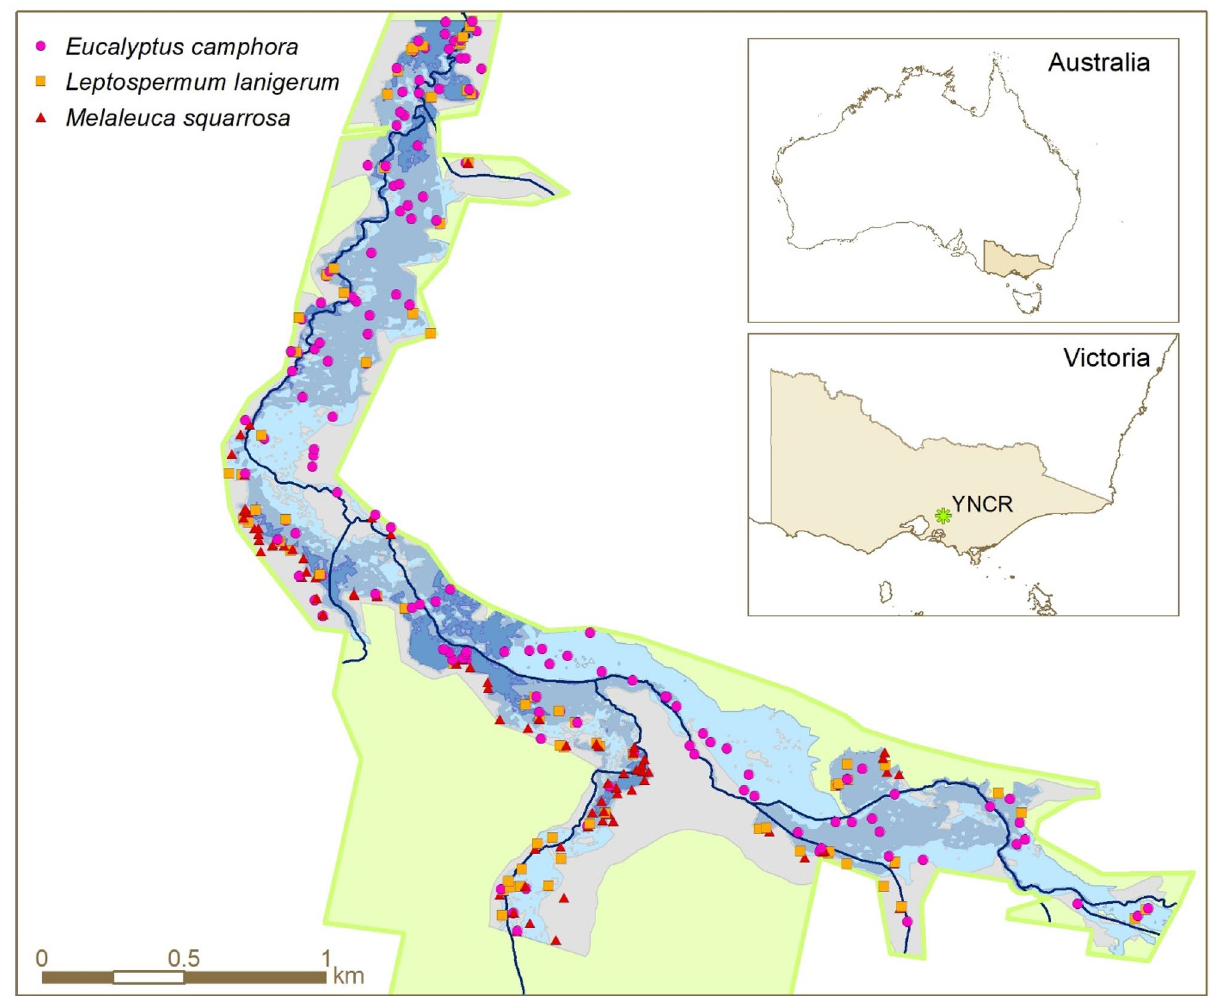
Figure 2. Map of all surveyed individuals of the three studied species within the Yellingbo Nature Conservation Reserve (green polygon). Shading represents flooding gradient categories used for sample point stratification (with grey indicating non-flood-prone areas and blues indicating flood-prone areas with darker blues representing higher flood-proneness). The map was generated in ArcMap version 10.5.1 (https:// deskt op. arcgis.